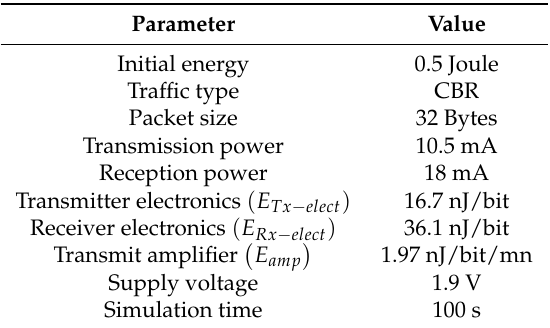
Table 2. Simulation parameters.